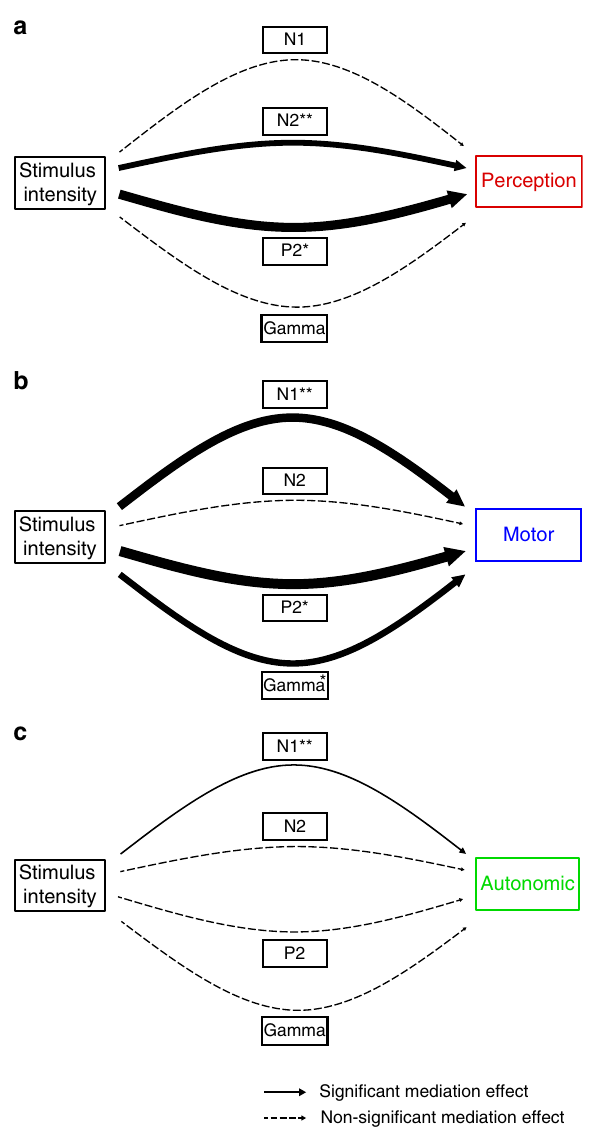
Fig. 5 Brain mediators of perceptual, motor, and autonomic responses to noxious stimuli. Mediation effects in the perception ( a ), motor ( b ), and autonomic ( c ) conditions. The thickness of the arrows re fl ects the size of the regression coef fi cients and thus, represents the strength of mediation effects. Signi fi cant mediation effects are indicated by continuous